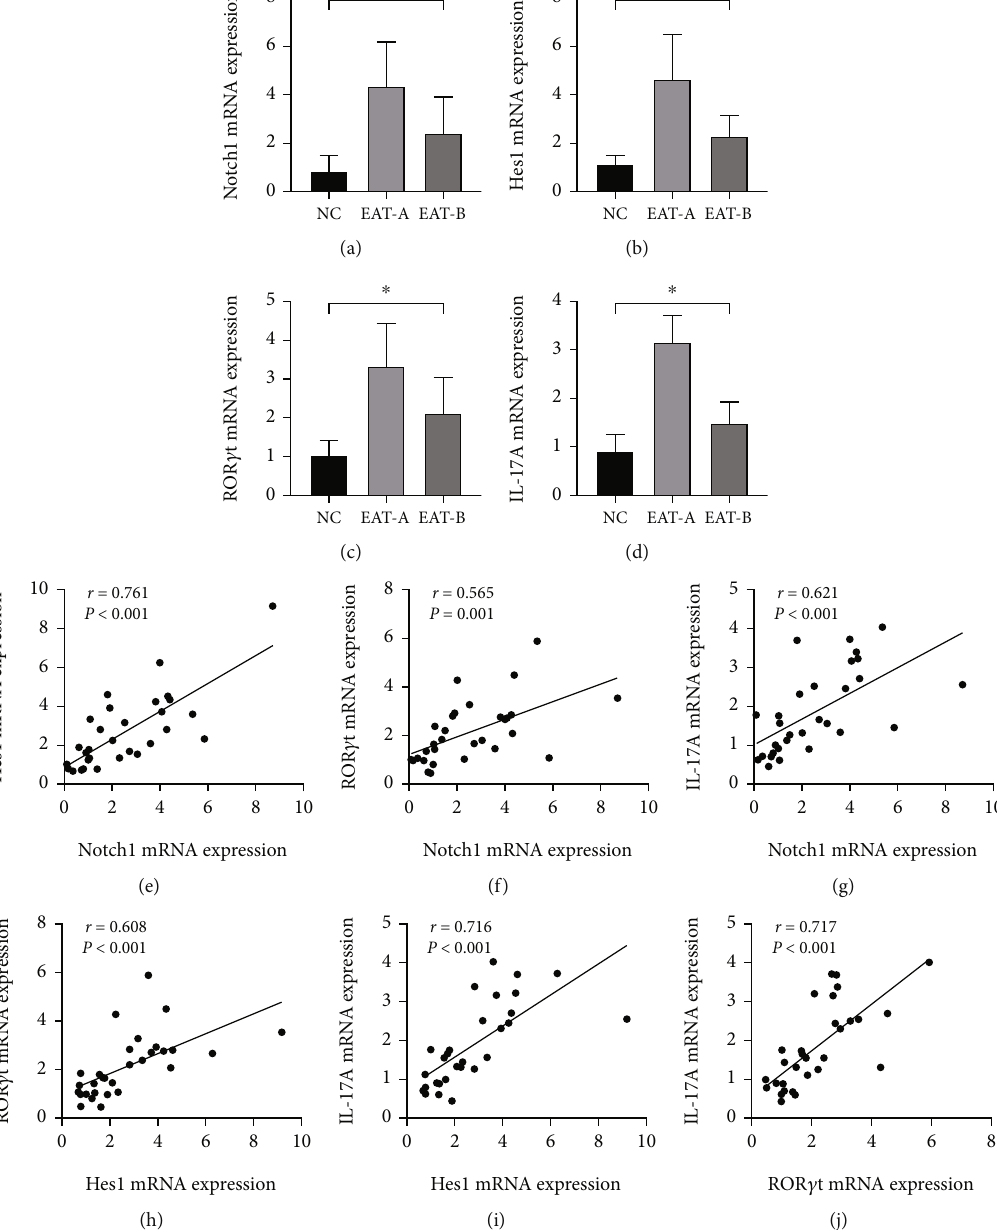
Figure 6: The Notch1, Hes1, ROR γ t, and IL-17A mRNA expression levels and correlation analyses of all genes ( n = 30 ). One-way ANOVA analyses revealed that the mRNA expression levels of Notch1, Hes1, ROR γ t, and IL-17A were signi fi cantly di ff erent among the three groups ( F = 15 : 186 , 22.909, 17.538, and 63 : 968 respectively, all ∗ P < 0 : 001 , (a – d)). (a) Altered expression of Notch1 mRNA (NC: 0 : 83 ± 0 : 65 ,